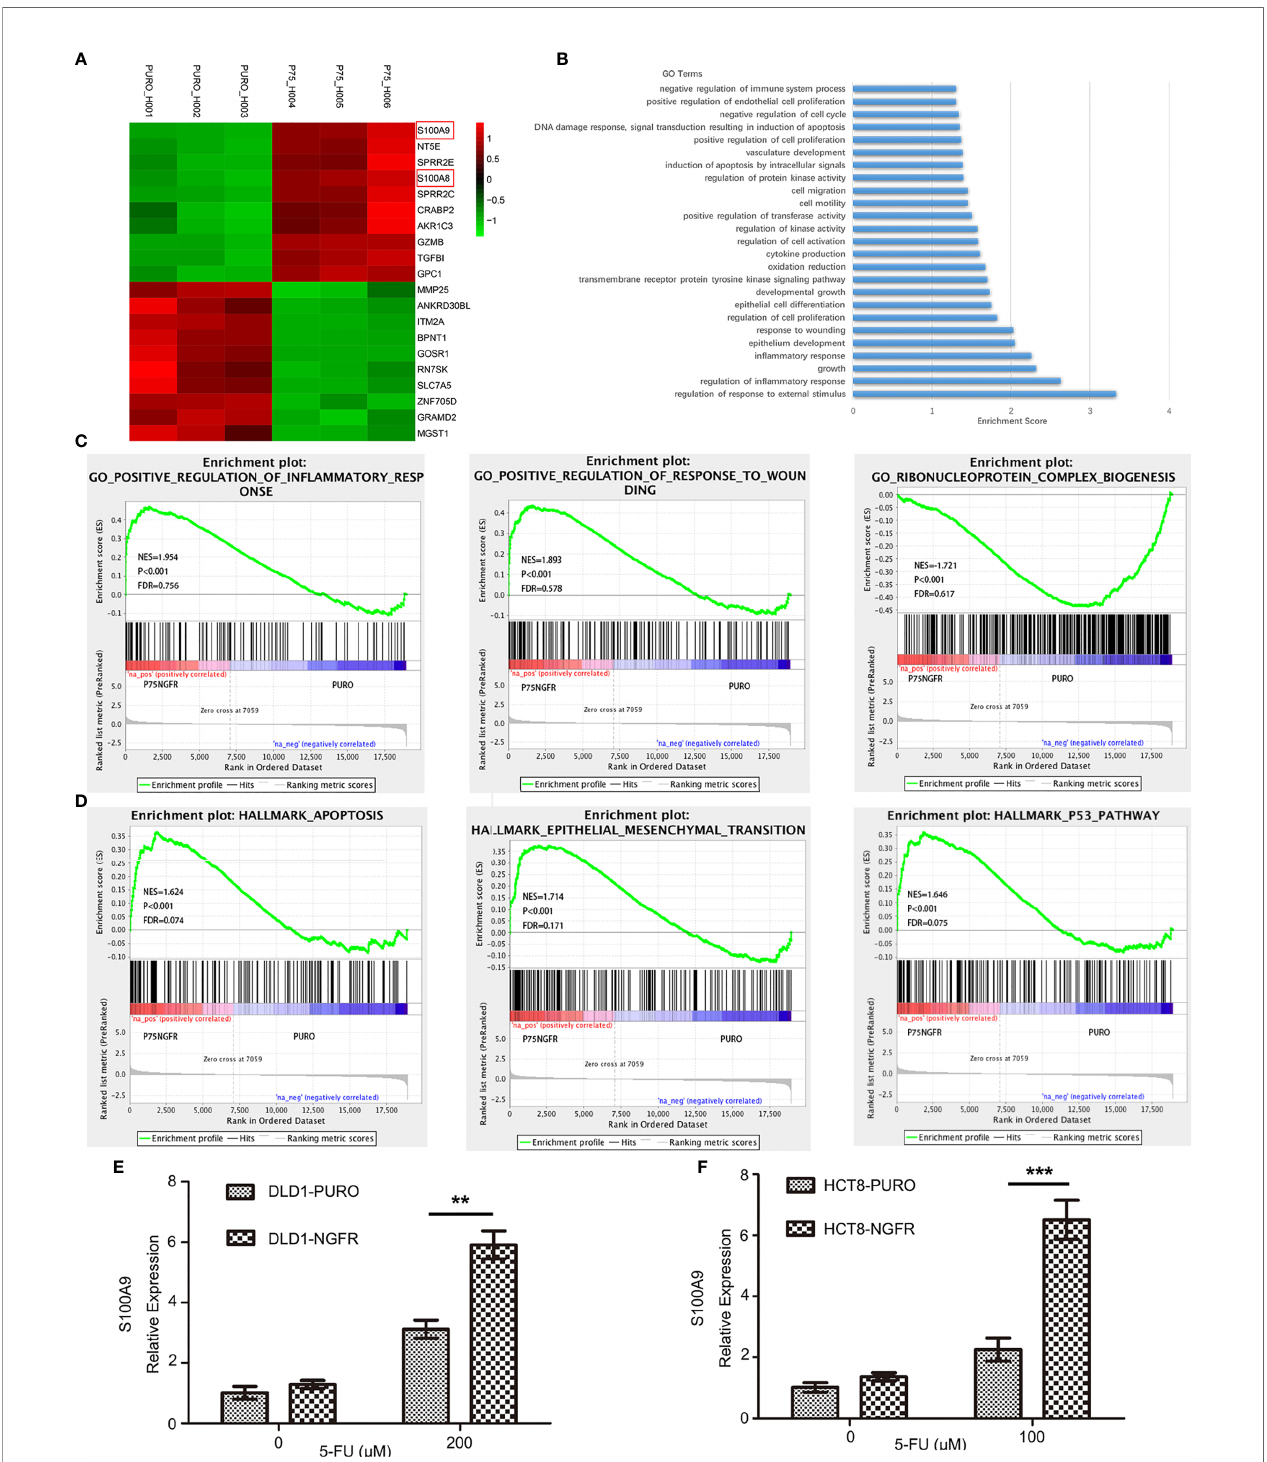
FIGURE 5 | RNA sequencing revealed potential downstream NGFR signaling. (A) The top 10 upregulated genes (red) and top 10 downregulated genes (green). S100A8 and S100A9 are marked with red frame. (B, C) Gene Ontology analysis of altered genes involved in biological process functions. (D) Gene Set Enrichment Analysis revealed enrichment of NGFR-associated genes. S100A9 upregulation shown in graphs of overexpressed NGFR – transfected (E) DLD1 and (F) HCT8 cells after 5-FU treatment. t-test; **P < 0.01; ***P <